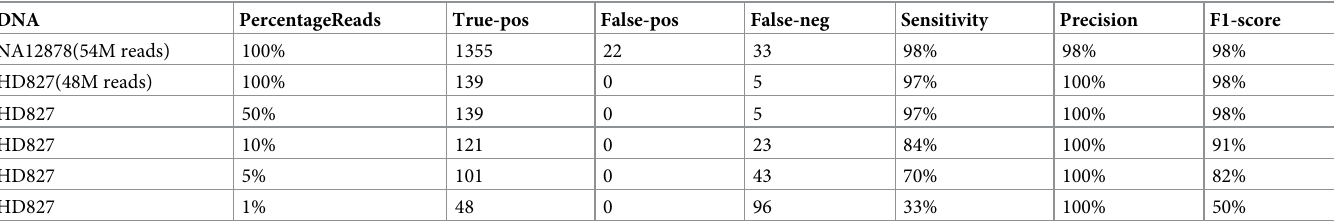
Table 2. Sensitivity and precision of ActSeq panel.